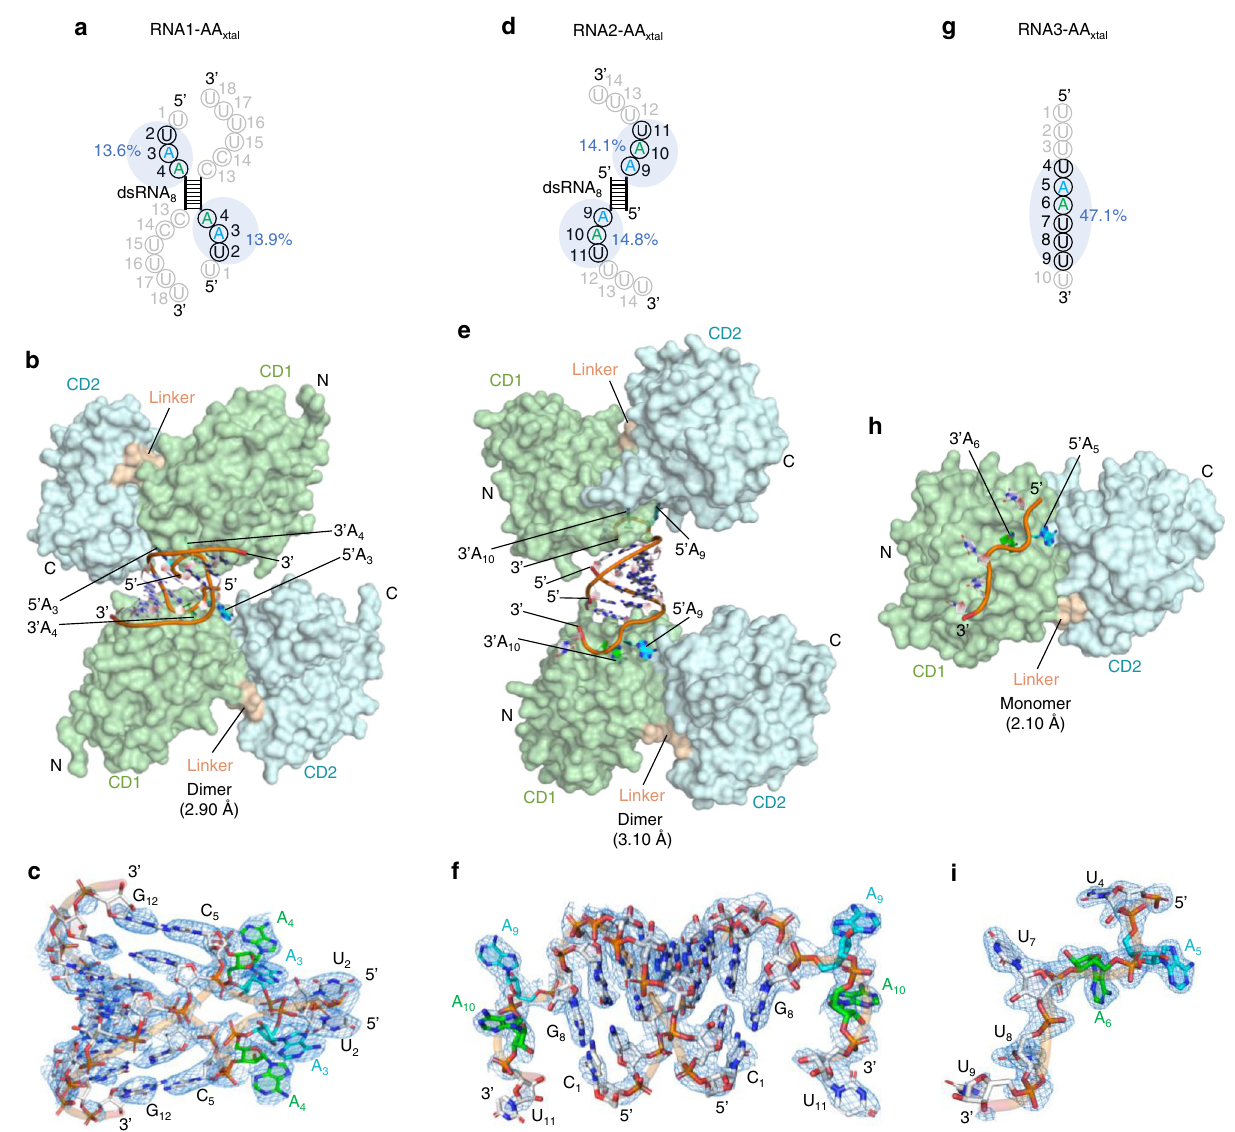
Fig. 2 | Overall architecture of rA3G R8/E259A in complex with three types of AA- containingRNA. Todistinguishthetwoadenosinesinthesequencemotif5 ′ -AA-3 ′ , we designated the 5 ′ -end A as 5 ′ A (in cyan) and the 3 ′ -end A as 3 ′ A (in green). a A schematicofthe5 ′ -overhangAAdinucleotidedsRNA(RNA1-AA xtal ). b Theco-crystal structure of rA3G R8/E259A and RNA1-AA xtal as a dimer (PDB ID: 7UU5). c A 2Fo-Fc electron density map of the resolved RNA1-AA xtal contoured at 1 σ level. d A schematic of the 3 ′ -overhang AA dinucleotide dsRNA (RNA2-AA xtal ). e The co- crystalstructureofrA3G R8/E259A andRNA2-AA xtal asadimer(PDBID:7UU3). f A2Fo- Fc electron density map of the resolved RNA2-AA xtal contoured at 1.5 σ level.